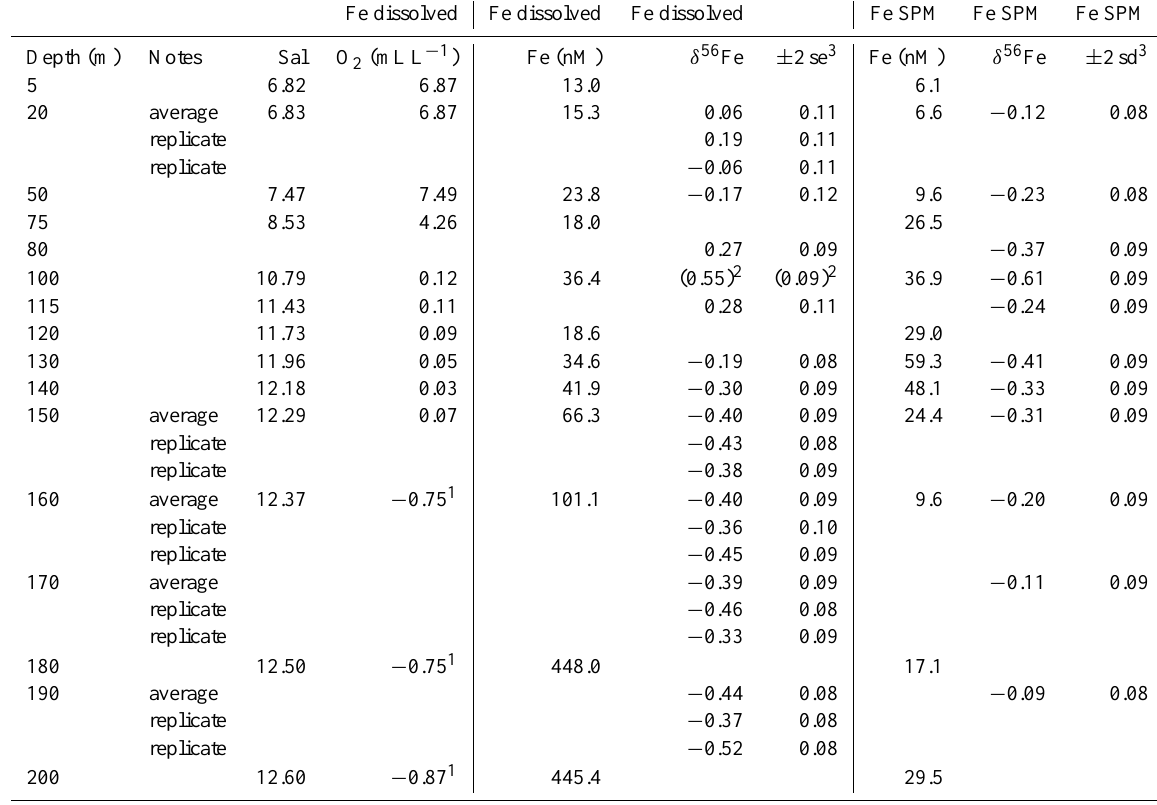
Table 1. δ 56 Fe of Fe dis and Fe SPM in the Eastern Gotland Basin. Fe dissolved Fe dissolved Fe dissolved Fe SPM Fe SPM Fe SPM Depth